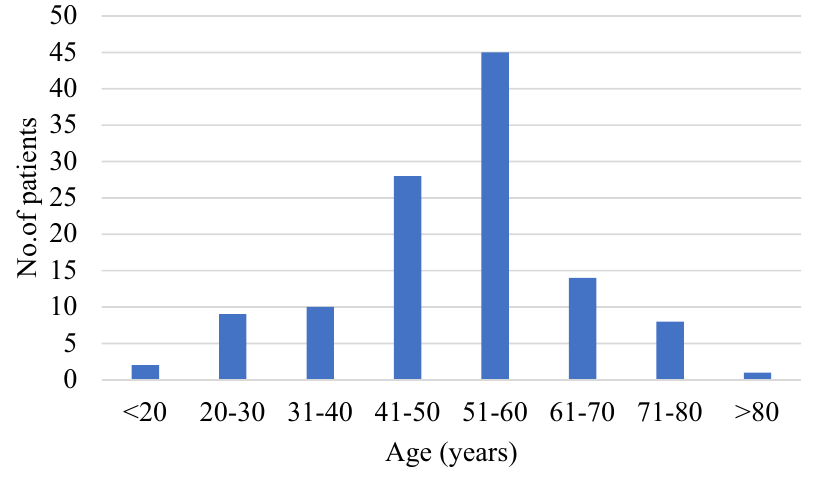
Figure 2. Age distribution of first onset in